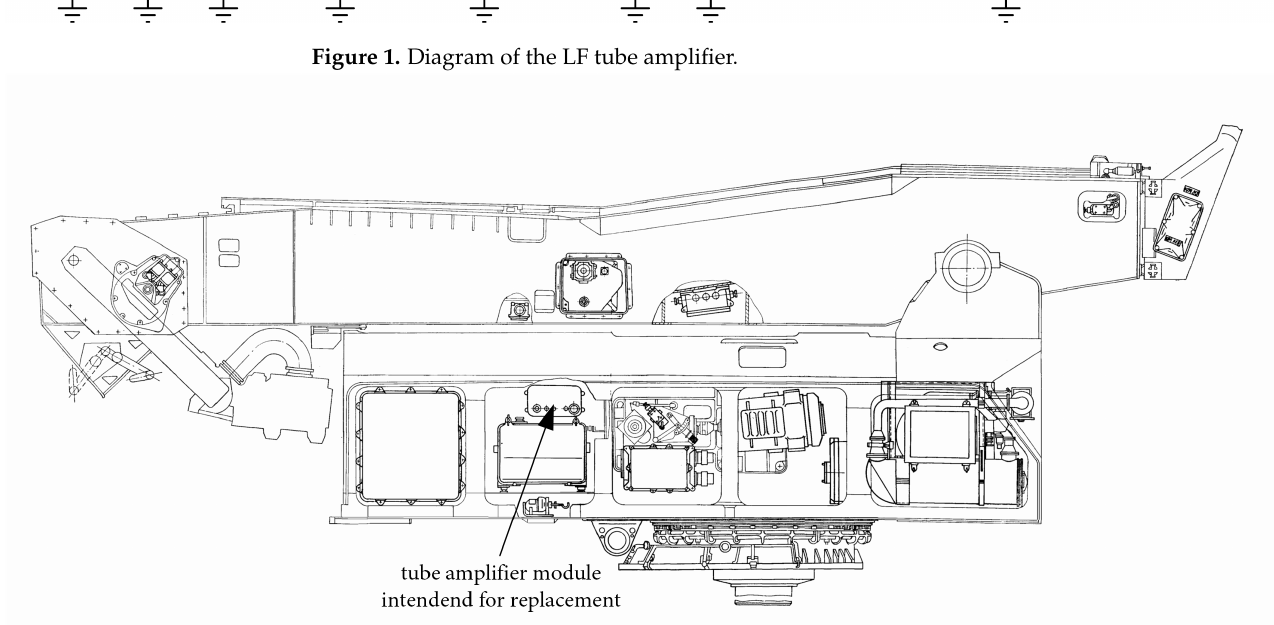
Figure 2. Side view of an anti-aircraft missile